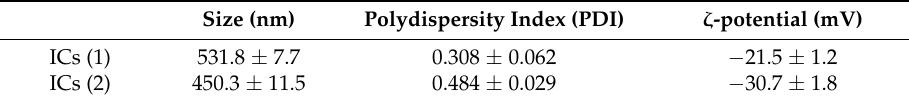
Table 1. Size, polydispersity index (PDI) and ζ -potential average values of the formed β -CD—oregano EO